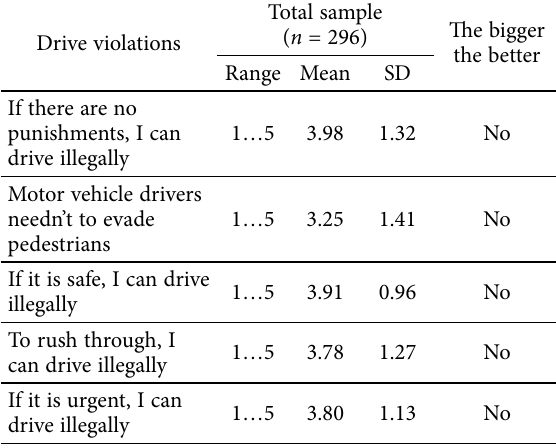
Table 3. Diver attitudes to diver attitudes to illegal driving